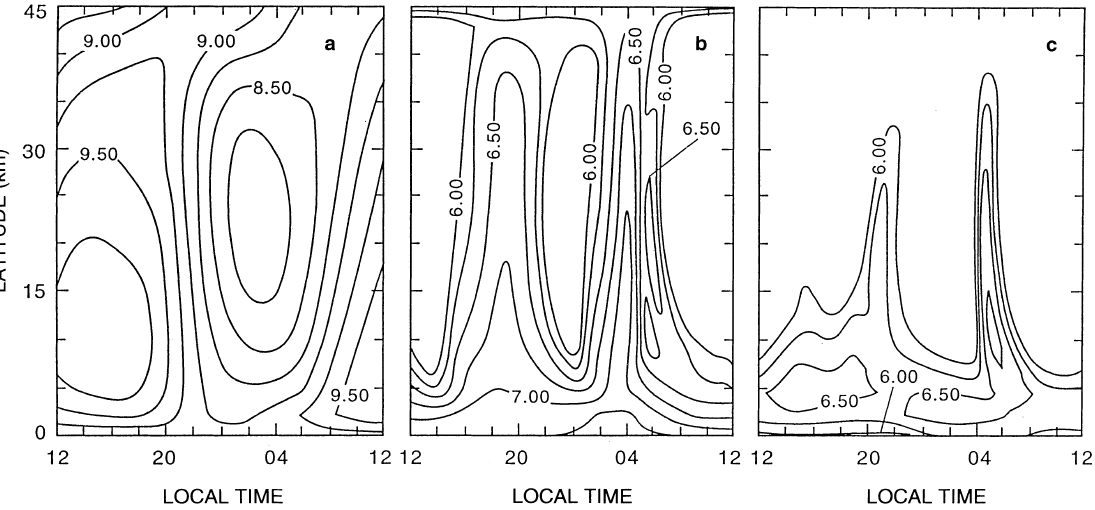
Fig. 9a–c. Same as Fig. 8, except due to transport by zonal and meridional winds (no electric